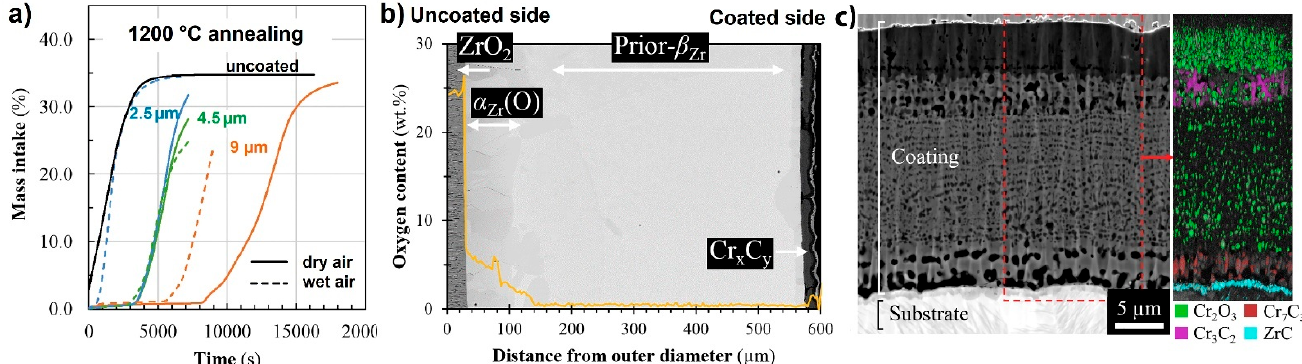
Figure 9. Mass gains measured by TGA of uncoated and Cr x C y -coated Zircaloy-4 under air oxidation isothermal air oxidation at 1200 °C ( a ); BSE SEM image and oxygen profiles of Cr x C y -coated clad segment after oxidation in steam at 1200 °C for 10 min, followed by water quenching ( b ); and the detailed SEM + EBSD image of the inner surface of Cr x C y -coated clad segment after the oxidation test ( c ). Reproduced from [ 146 ] with permission by Elsevier.